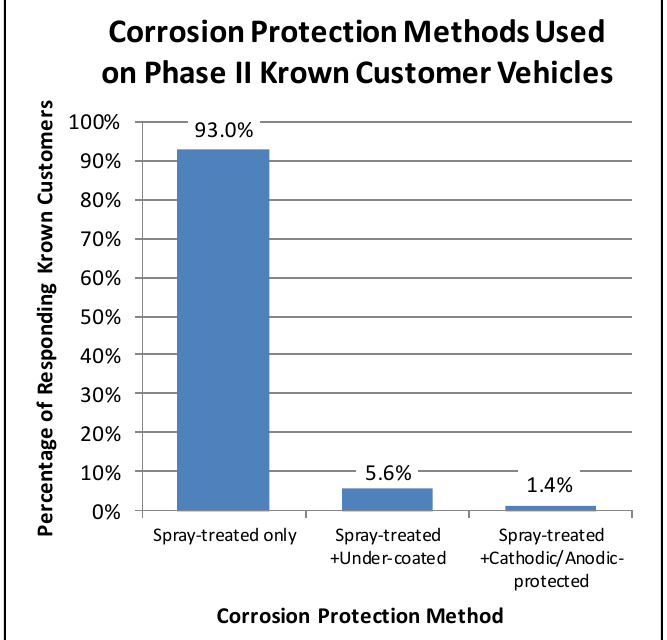
Figure 1. Proportions of Phase II surveyed customers’ vehicles having received different combinations of corrosion treatments.